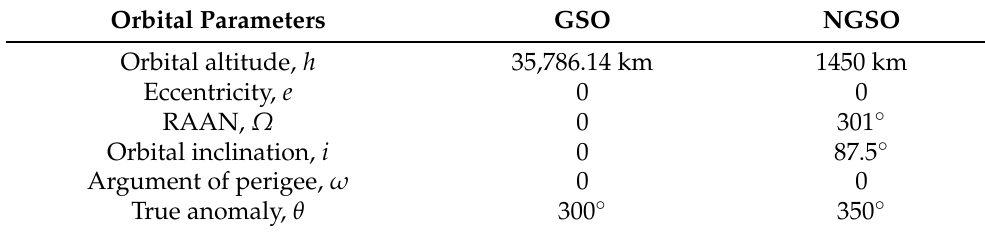
Table 3. Orbital parameters of GSO and NGSO